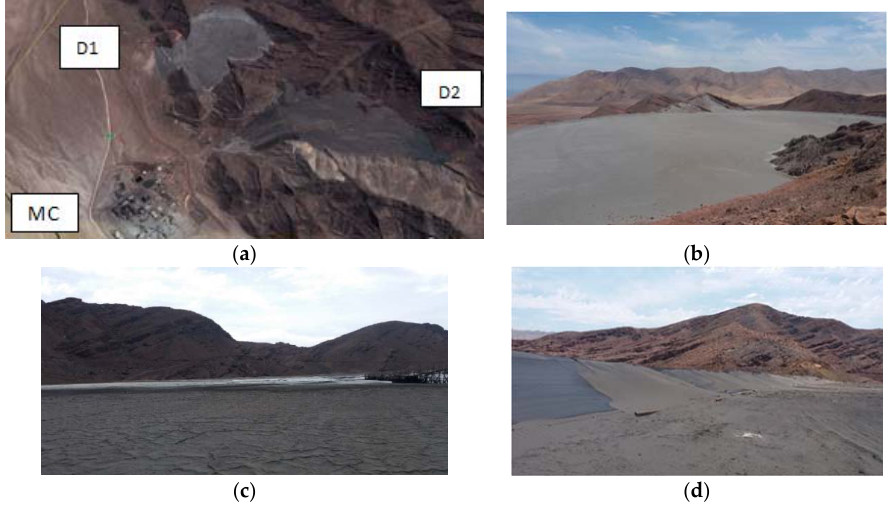
Figure 2. ( a ) Study area, tailings Dam 1 (D1) currently closed; ( b ) Dam 1 (close ‐ up view); ( c and d ) tailings Dam 2 (D2).